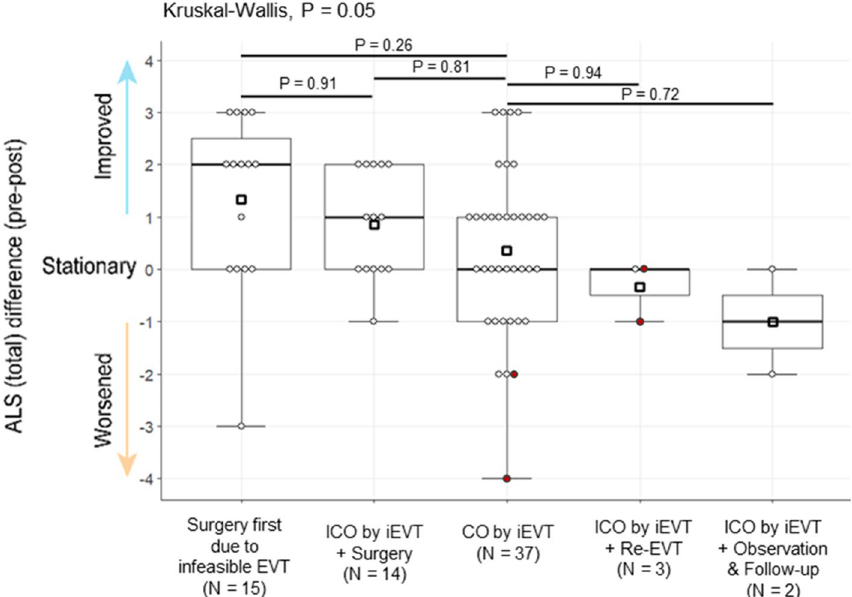
Figure 4. Scatter bar plot showing the comparison of functional outcomes of patients who underwent different treatment courses. Circles denote each patient; red-filled circles denote patients with complications; squares denote the mean value of ALS (total) difference (pre-post). EVT endovascular treatment; ALS Aminoff- Logue scale; CO complete occlusion; iEVT initial EVT; ICO incomplete occlusion; Re-EVT repeated EVT; FU